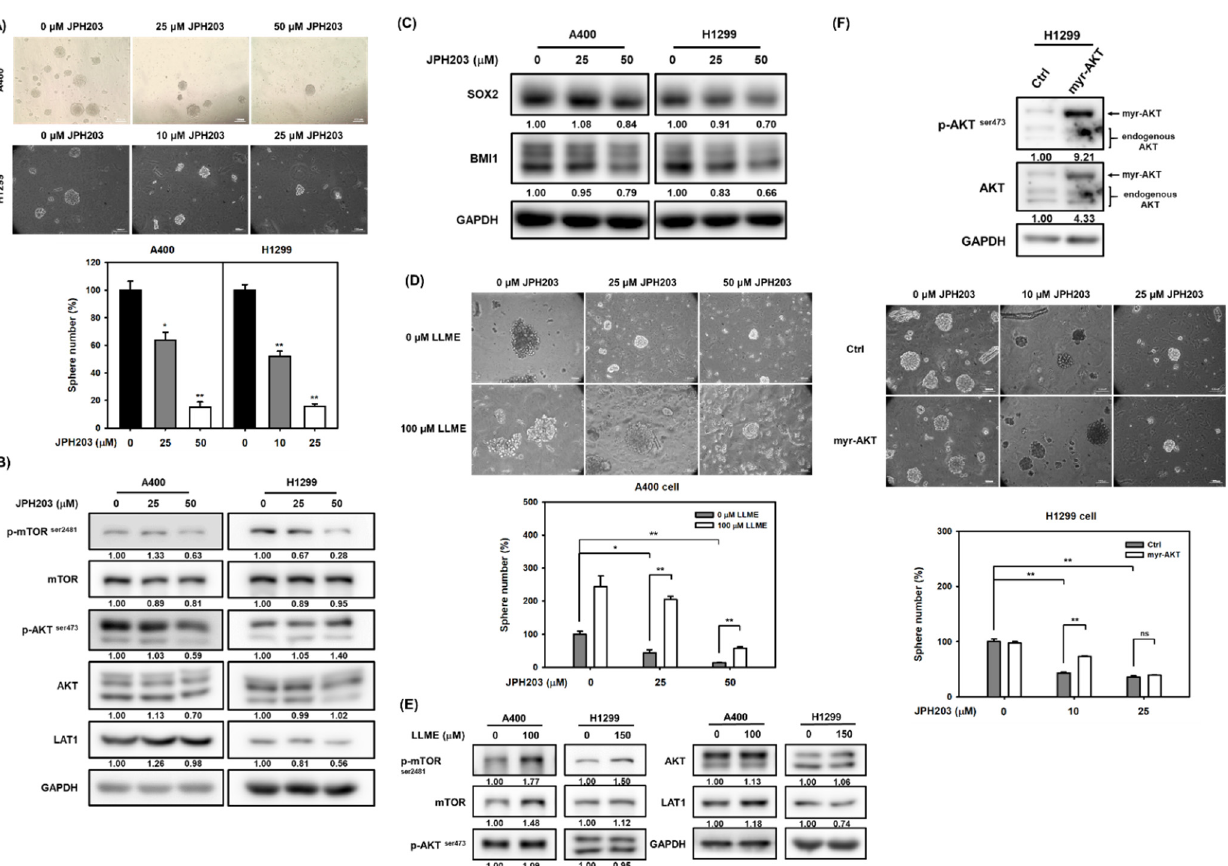
Figure 3. Inhibition of LAT1 activity by JPH203 suppresses CSC activity and Akt/mTOR activation in NSCLC cells. ( A ) The CSC activity of A400 and H1299 cells was determined by tumorsphere cultivation, and pictures were presented at 100× magnification. The quantitative data were presented as relative percentages to the tumorsphere number of the 0.1% DMSO treated group (0 μ M). The inserted scale bars indicate 100 μ m in length* p < 0.05; ** p < 0.01. ( B ) The protein expressions of phosphor-mTOR ser2481 , mTOR, phosphor-Akt ser473 , Akt, and LAT1 were determined by Western blot analysis. GAPDH was used as a protein-loading control. The inserted numbers presented are relative expression folds in comparison to the 0.1% DMSO treated group (0 μ M) after normalization with the internal control of GAPDH. ( C ) The protein expression of BMI1 or SOX2 was determined by Western blot. The inserted numbers indicated relative expression levels as compared to DMSO group after normalization to the internal control of GAPDH. ( D ) The CSC activity of A400 cells under JPH203 treatment with or without 100 μ M LLME cotreatment was determined by tumorsphere cultivation and pictures were presented at 200× magnification. The quantitative data were presented as relative percentages of the tumorsphere number of the 0.1% DMSO without LLME treatment group. The inserted scale bars indicate 100 μ m in length. * p < 0.05; ** p < 0.01. ( E ) The protein expressions of phosphor-mTOR ser2481 , mTOR, phosphor-Akt ser473 , Akt, and LAT1 in A400 and H1299 cells in the presence of LLME were determined by Western blot analysis. GAPDH was used as a protein-loading control. The inserted numbers are presented as relative expression folds in comparison to the cells without LLME treatment group after normalization to GAPDH. ( F ) The CSC activity of H1299 cells under JPH203 treatment with or without the overexpression of the myr-Akt vector was determined by tumorsphere cultivation, and pictures were presented at 100× magnification. The inserted scale bars indicate 100 μ m in length. The quantitative data were presented as relative percentages of the tumorsphere number of the control vector transfected and 0.1% DMSO treatment group. The overexpression of myr-Akt (upper panel) was determined by Western blot analysis. ** p < 0.01. ns, not significant.